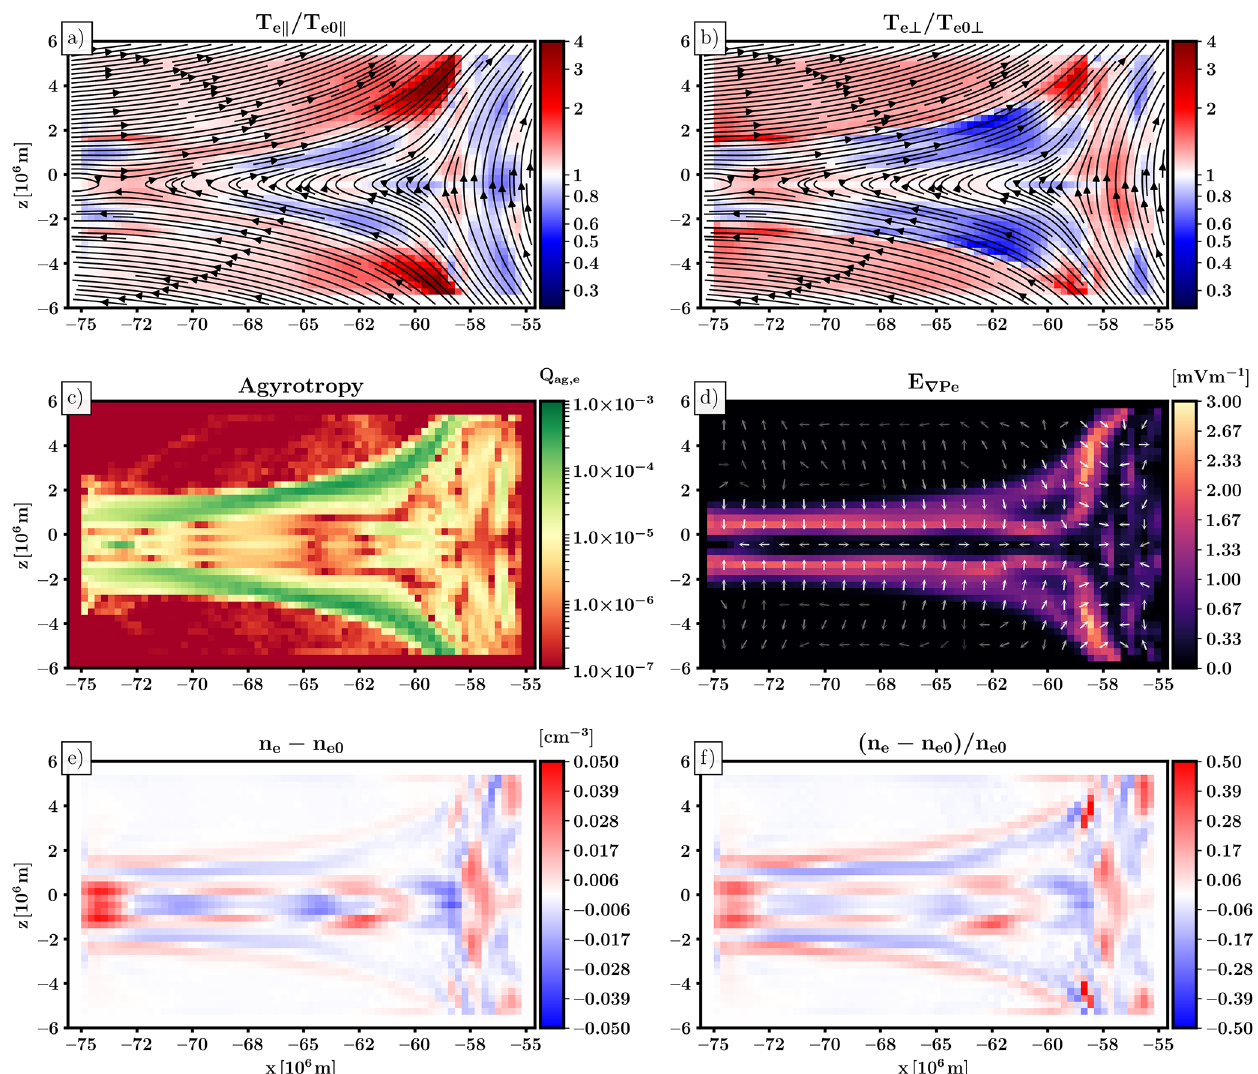
Figure 6. Electron distribution properties within the test domain after 1.0s of simulation. (a) The ratio of parallel electron temperature at 1.0s to the parallel temperature at the start of the simulation, indicating parallel heating. (b) The same but for perpendicular temperature. (c) The agyrotropy measure for the electron population. (d) The magnitude and direction of the electron pressure gradient term of the electric field. (e, f) The charge imbalance n e − n e , 0 and relative charge imbalance (n e − n e , 0 )n − 1 found at the end of the e , 0